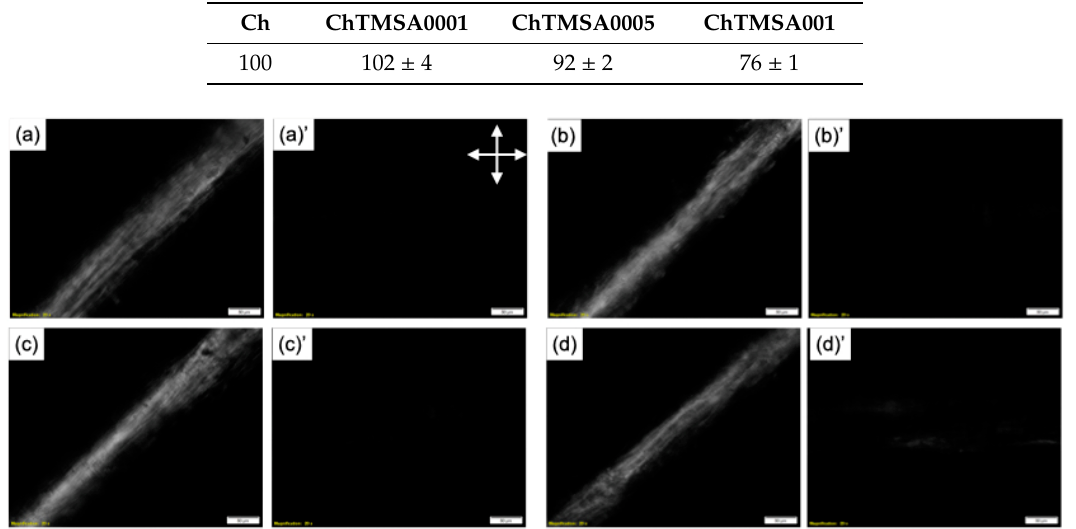
Figure 5. Optical microscope images of the chitosan − TMSA microfibers obtained with crossed nicols at 45° ( a – d ) and 90° ( a ) ′ –( d ) ′ . ( a ) and ( a ) ′ Ch; ( b ) and ( b ) ′ ChTMSA0001; ( c ) and ( c ) ′ ChTMSA0005; and ( d ) and ( d ) ′ ChTMSA001. The arrows indicate the direction of the nicols.